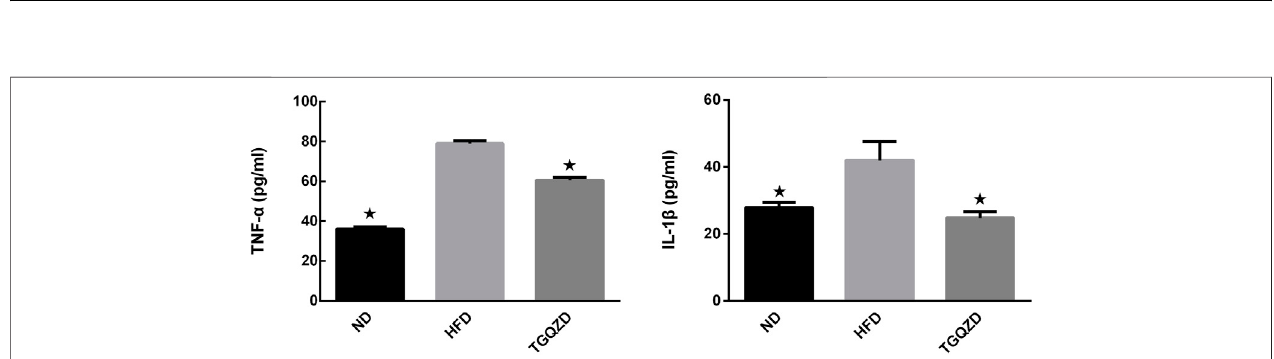
FIGURE 3 | Effect of TGQZD on FFA and ROS content in liver of NAFLD rats. Compared with the ND group, the content of FFA and ROS in the liver of NAFLD rats was signi fi cantly increased ( p < 0.05), while compared with the HFD group, TGQZD signi fi cantly reduced the level of FFA and ROS in the liver of NAFLD rats ( p < 0.05). * p < 0.05 vs. HFD Group, alone.